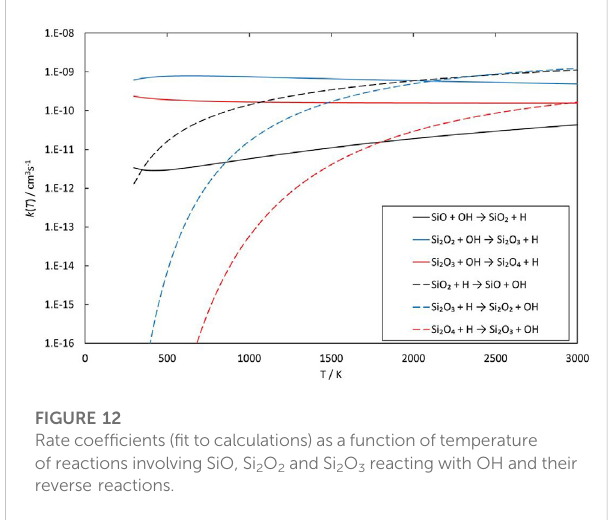
FIGURE 12 Rate coef fi cients ( fi t to calculations) as a function of temperature of reactions involving SiO, Si 2 O 2 and Si 2 O 3 reacting with OH and their reverse reactions.